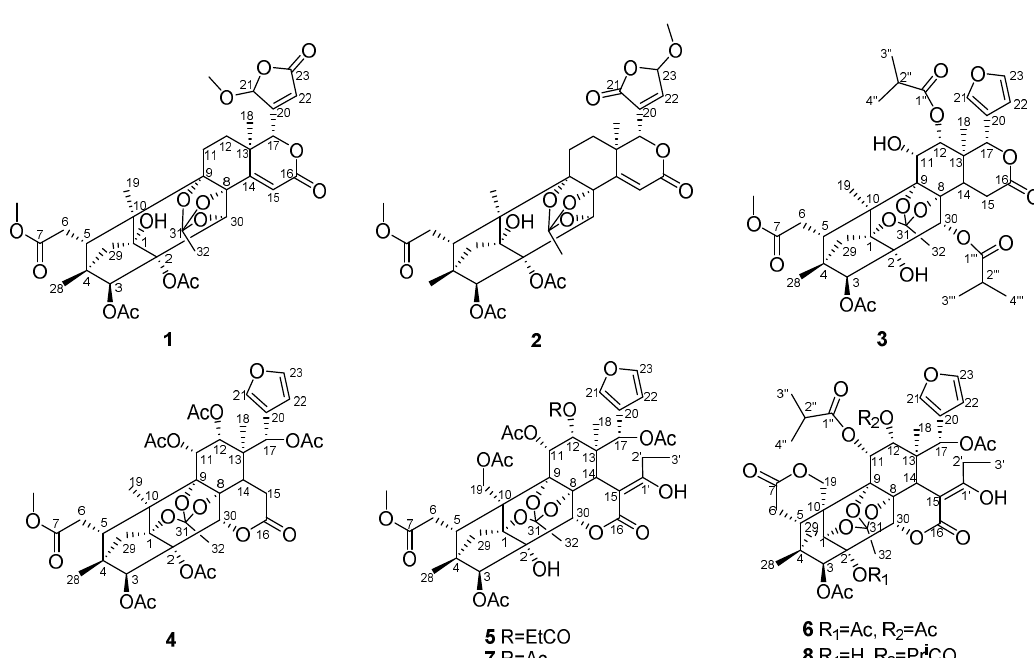
Figure 1. The chemical structures of compounds 1 – 8 .